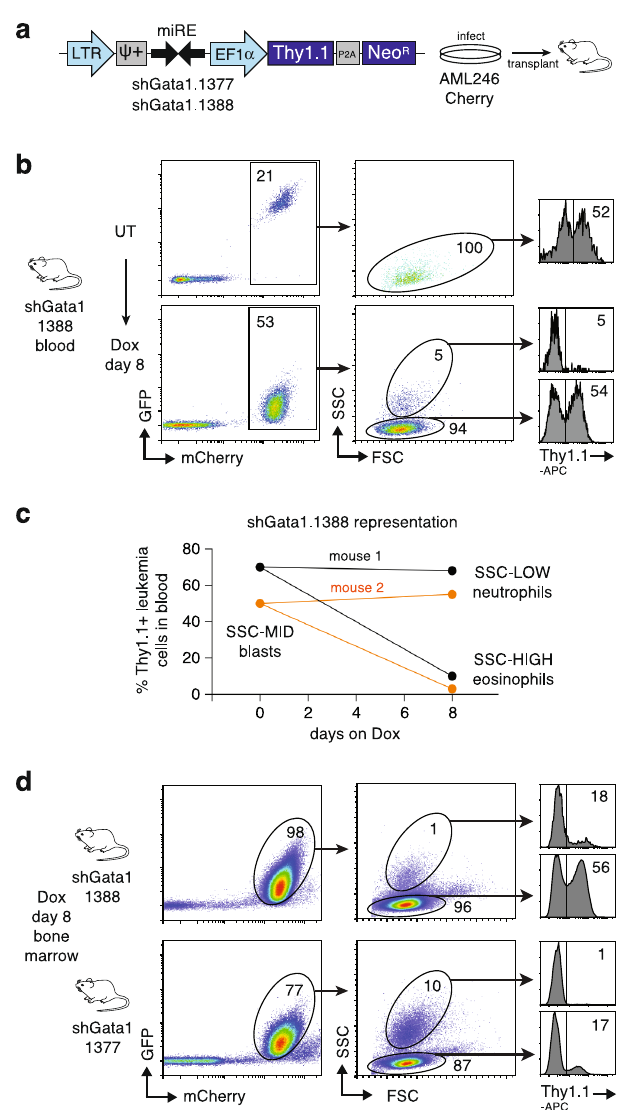
Fig. 5 Gata1 knockdown prevents eosinophilic maturation of AML246. a Schematic of the LETN shRNA vector co-expressing the surface marker Thy1.1. b Flow cytometry of blood from a representative mouse transplanted with AML246-Cherry stably transduced with LETN- shGata1.1388, either untreated or after 8 days Dox. c Proportion of Thy1.1 + (shGata1.1388 expressing) leukemia cells within each indicated population in the blood of two representative mice before and after 8 days on Dox. d Flow cytometry of bone marrow from representative mice harboring AML246-Cherry transduced with LETN-shGata1.1388 or shGata1.1377 following 8 days of Dox